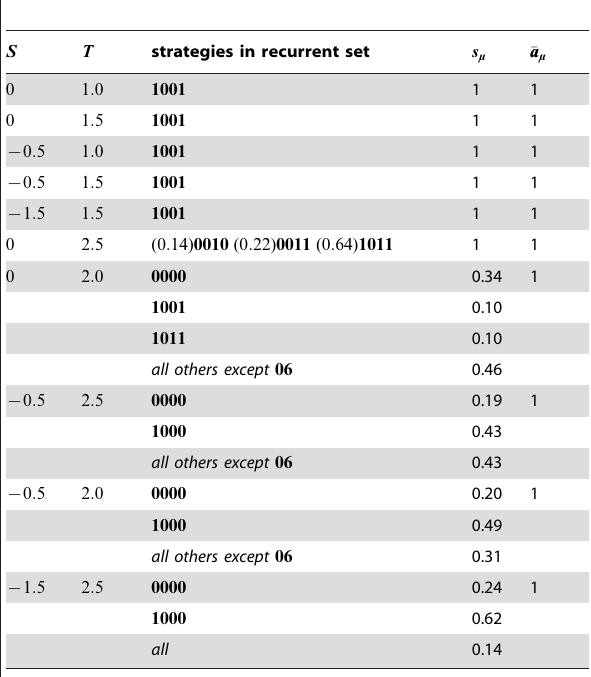
Table 3. Recurrent sets found in the Prisoner’s Dilemma game